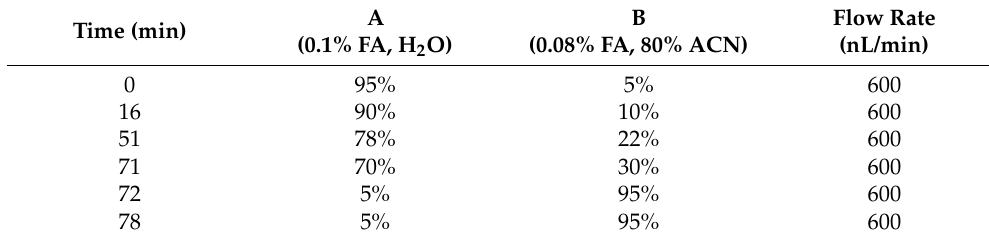
Table 2. Liquid chromatography elution gradient